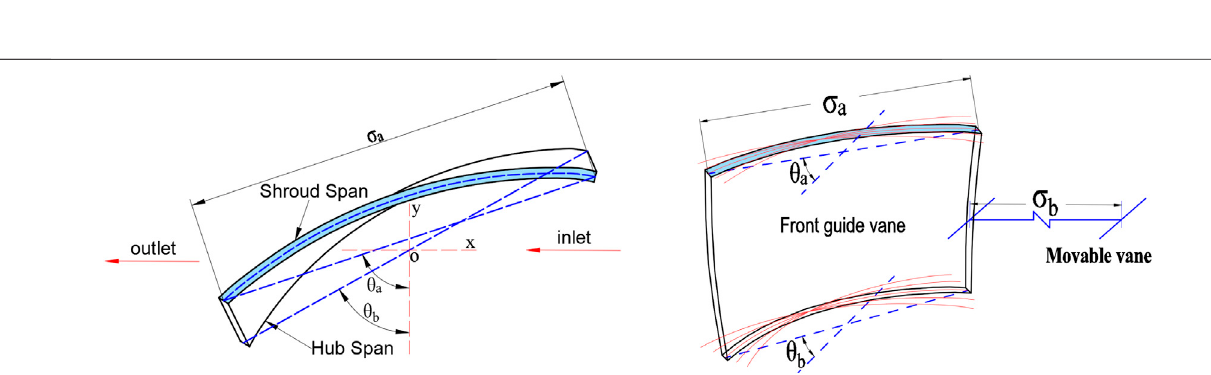
FIGURE 7 | Geometric parameters of fan guide